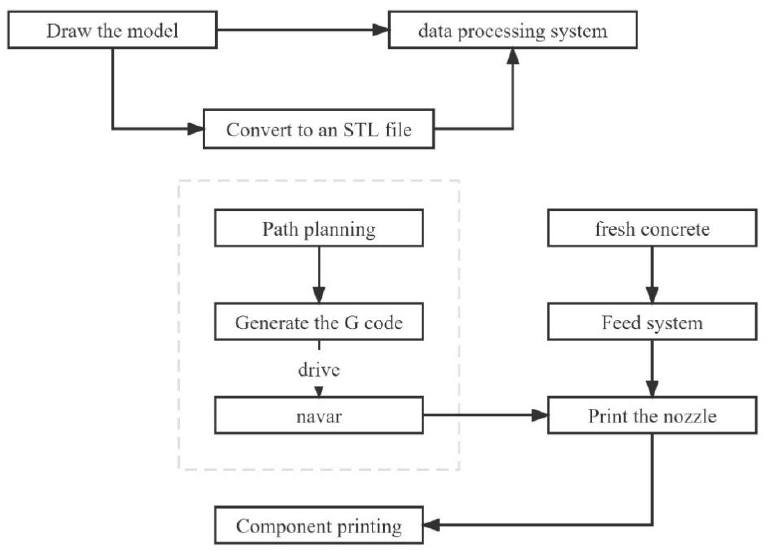
Figure 2. Workflow of the 3D printing process.